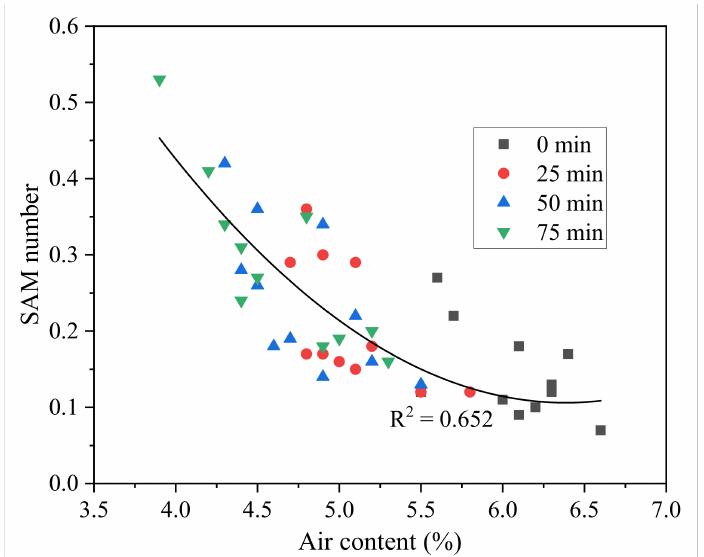
Figure 8. Correlation between SAM number and air